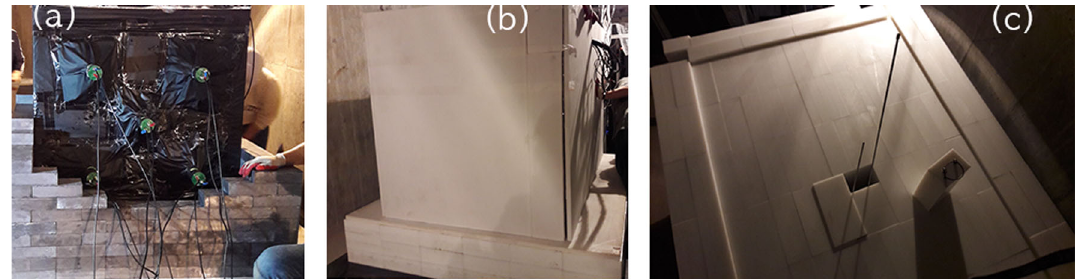
Fig. 3 Pictures of the NEON shield during installation. a The LS container and readout PMTs are surrounded by 10cm lead bricks. b The lead castle is surrounded by 2.5cm thick borated PE and c 20cm high density PE. Two calibration tubes installed with the calibration rods (sources) are